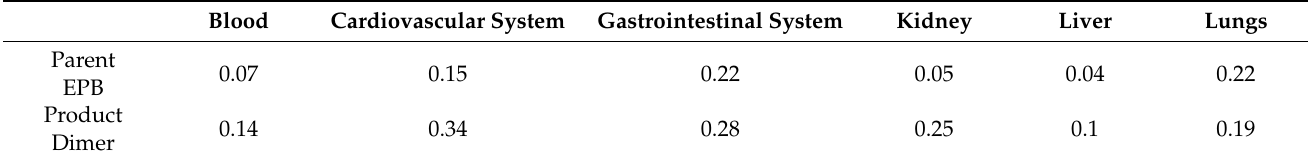
Table 3. Probability ( p ) value of health effects.